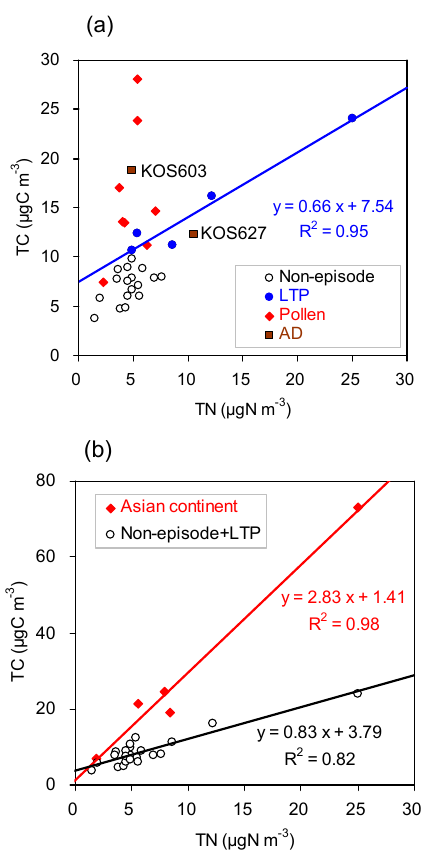
Fig. 6. (a) Scatter plot between mass concentrations of TN ver- sus TC during the entire sampling period. Filled blue circle, red diamond, and brown rectangular represent the LTP, pollen, and AD+LTP episodes, respectively. (b) Mass concentrations of TN and TC during the non-episode plus LTP episode are compared to those from previous studies on the Asian continent. TN and TC values on the Asian continent were obtained from urban areas of China: Shanghai in winter and spring (size cut: PM 2 . 5 , sampling flow rate: 0.4lmin − 1 , integration time: weekly) (Ye et al., 2003), Nanjing in winter (PM 2 . 5 , 1110lmin − 1 , 12h) (Yang et al., 2005), Baoji in spring (PM 10 , 100lmin − 1 , 8h) (Wang et al., 2010) as well as the Hua mountain site in winter (PM 10 , PM 10 , 100lmin − 1 , 10h) (Li et al., 2011). The analytical errors for TC and TN mass concen- trations at the Gosan site were 2.3% and 5.2%,